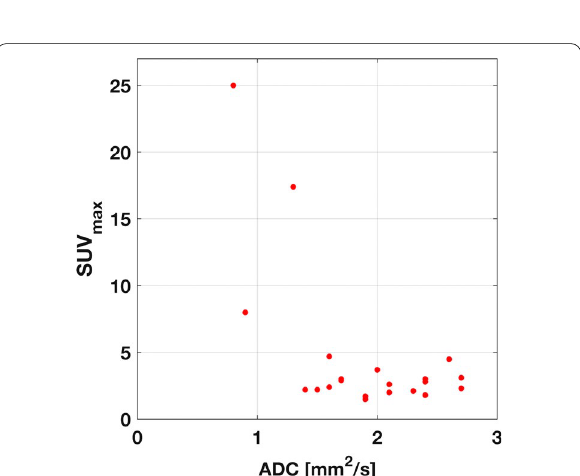
Fig. 2 Correlation plot between SUV max and ADC values. The y-axis represents the SUV max values, and the x-axis represents the ADC values for all